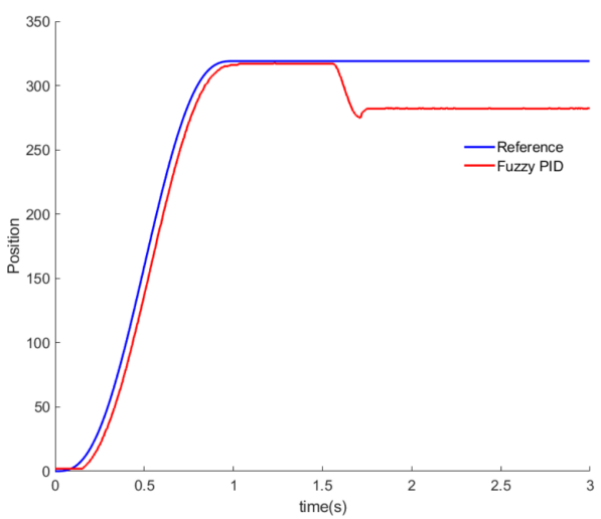
Figure 24. Grasp angle of the fuzzy proportional-integral-derivative (PID) controller.